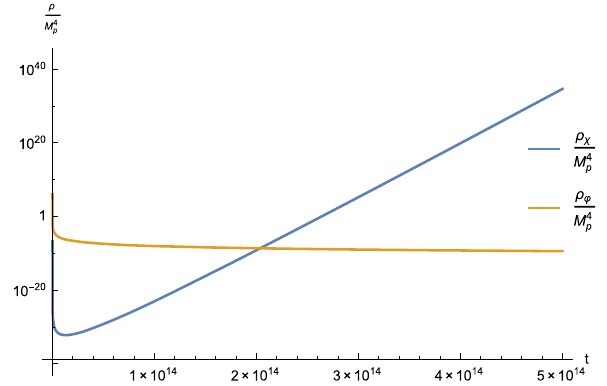
Fig. 5 The numerical plot of ρ χ and ρ ϕ in terms of the cosmic time t . The time point when the two lines cross over corresponds to the time when the back-reaction becomes important. We choose the parameters as ξ = 1, M = 10 − 4 M p , m = 10 − 6 M p , g = 4 . 8 × 10 −